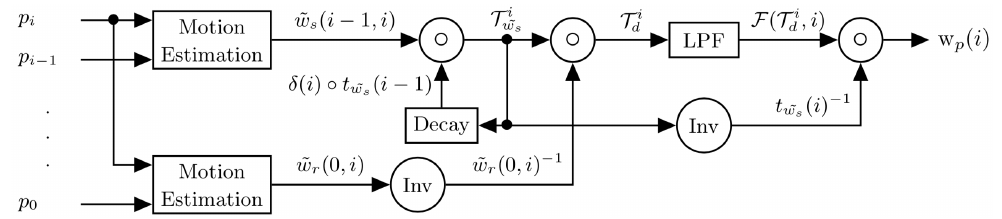
Figure 4. Overview of the proposed method. “Inv” corresponds to an inversion in the space of warping transforms; LPF stands for low-pass